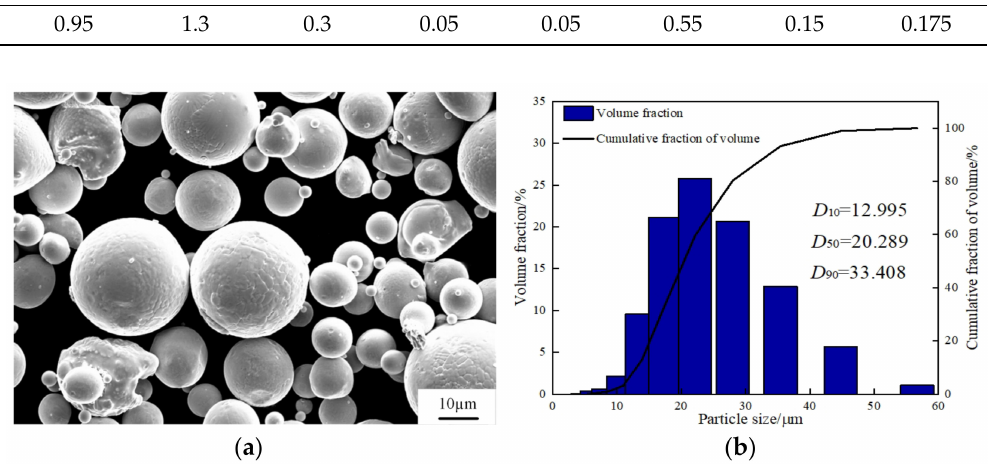
Figure 2. SLM 6061 aluminum alloy powders: ( a ) morphology; ( b ) size